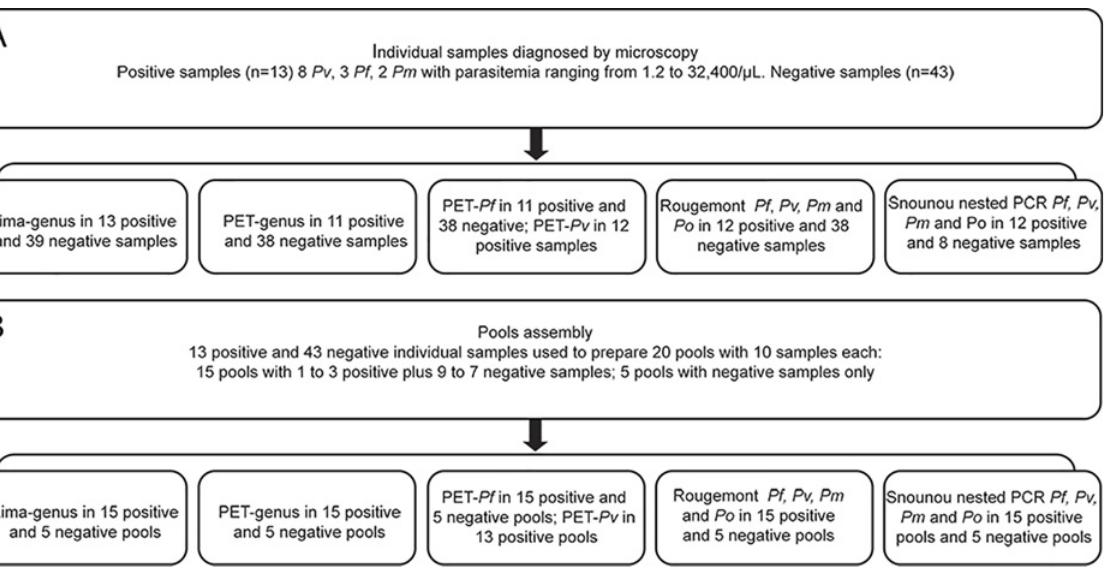
Fig 1. Blood samples and molecular assays used for detection of Plasmodium . (A) Individual samples detected by microscopy and number of samples assayed by different molecular tests. (B) Pooling of positive and negative samples assayed by different molecular tests.